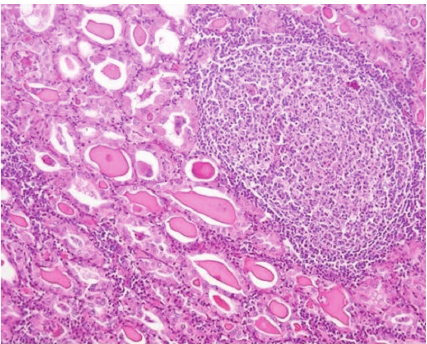
Figure 4: Thyroid histopathology showing destruction of thyroid follicles. Numerous lymphoid follicles were seen with lymphocytes infiltrating into the surrounding fibrocollagenous tissue.